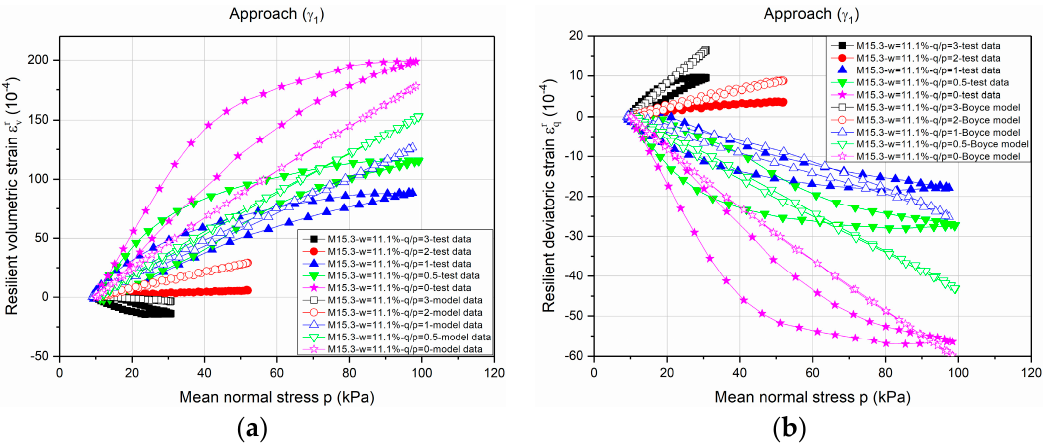
Figure 7. Modelling of ε vr and ε qr based on γ 1 and γ 1 * for Missillac sand M15.3 at water content of w = 11.1%. ( a ) ε vr ; and ( b ) ε qr .